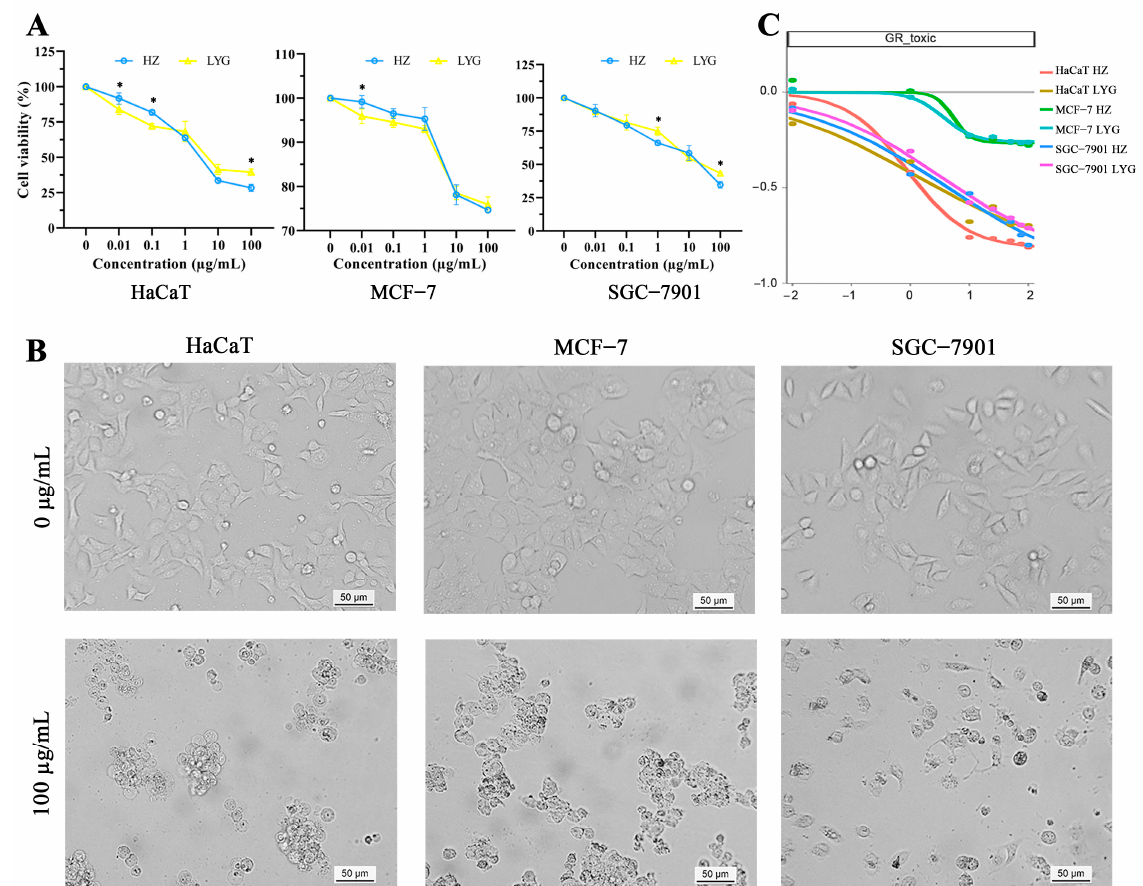
Figure 3. Morphological changes and dose-dependent effects of toad venom specimens from HZ and LYG on the viability and growth rate inhibition (GR) of HaCaT, MCF–7, and SGC–7901 cells. ( A ) Cytotoxicity of the HZ and LYG specimens in three types of cells was determined by an MTT assay. Values are presented as means ± SD, N = 5. * p < 0.05 compared between the HZ and LYG specimens at the same concentration. ( B ) Morphological changes in the three types of cells following treatment with protein components of toad venom. ( C ) GR of the HZ and LYG specimens in three types of cells.